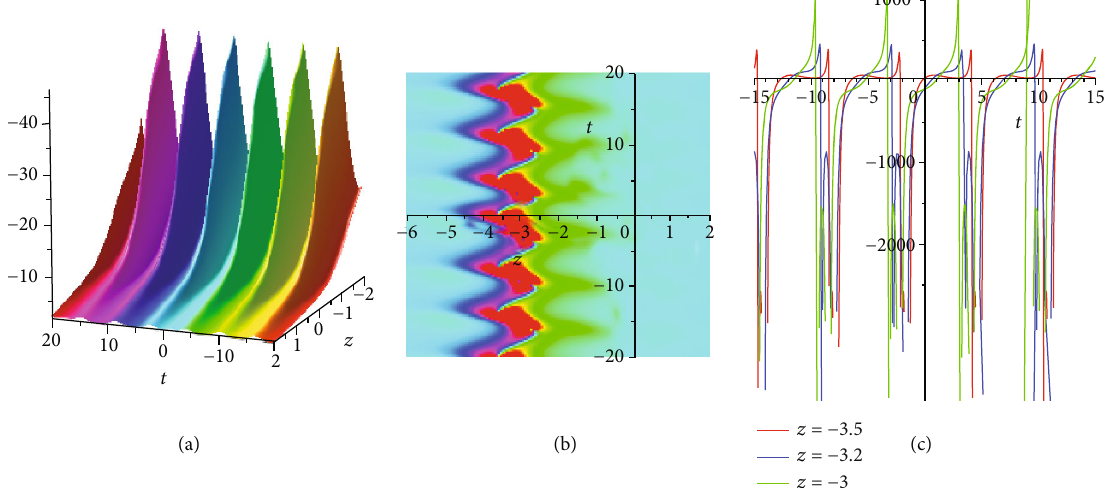
Figure 17: Plots of lump-periodic